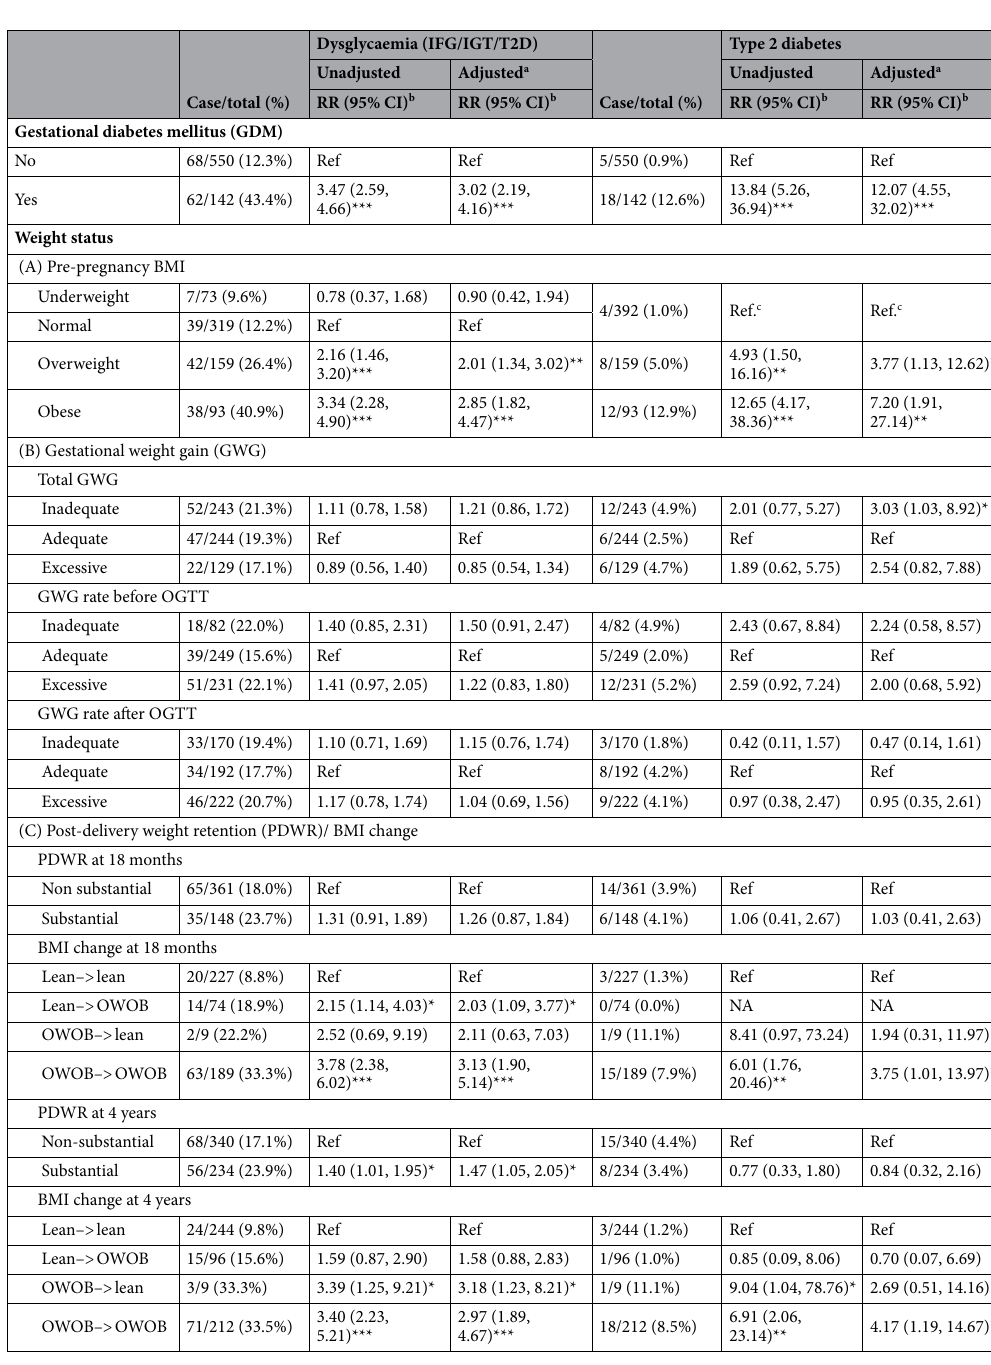
Table 2. Prospective associations of gestational diabetes and weight status from pre-pregnancy through post-delivery periods, with dysglycaemia and type 2 diabetes risks at 4–6 years post-delivery. IFG impaired fasting glucose, IGT impaired glucose tolerance, T2D type 2 diabetes, RR relative risk, Ref. reference, BMI body mass index, GDM gestational diabetes mellitus, GWG gestational weight gain, PDWR post-delivery weight retention, OWOB overweight or obese. * P < 0.05; ** P < 0.01; *** P < 0.001. a Adjusted for ethnicity, age at delivery, education, parity, family history of diabetes, insulin treatment during pregnancy and pregnancy induced hypertension. b Estimates are relative risk (95% CI) for dysglycaemia and type 2 diabetes post-delivery according to the studied exposure. c Due to insufficient cases of T2D in underweight categories and because the relationship between pre-pregnancy BMI and dysglycaemia appeared linear, we combined underweight and normal weight categories into reference group for this